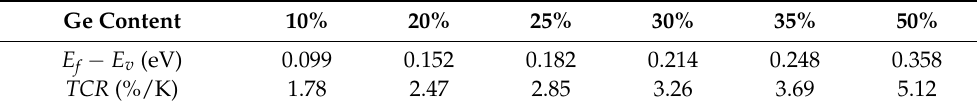
Figure 1. SEM photograph of the SiGe/Si MQWs with the 30% Ge content and diagram of its energy band. Table 1. The TCR calculation results of the SiGe/Si MQWs with different Ge concentrations.